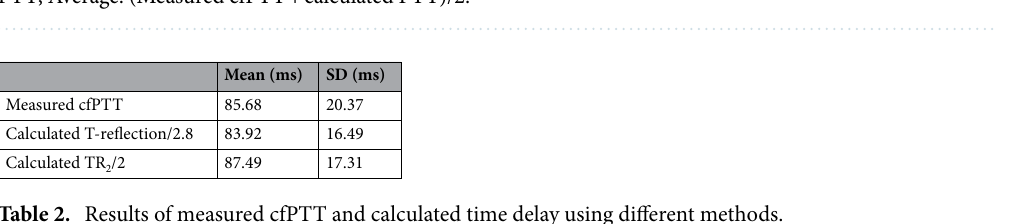
Figure 7. Correlation graphs and Bland–Altman plots comparing measured and calculated PTTs. ( A ) Scatter plot of the calculated PTT (T-reflection/2.8) vs measured carotid to femoral transit time (cfPTT) with regression line (dashed line) for all data. ( B ) Bland Altman plot of T-reflection/2.8 vs cfPTT for all data. Solid line is the mean difference, and the dashed lines are ± 1.96 SD of the difference. Difference: Measured cfPTT − calculated PTT; Average: (Measured cfPTT + calculated PTT)/2.